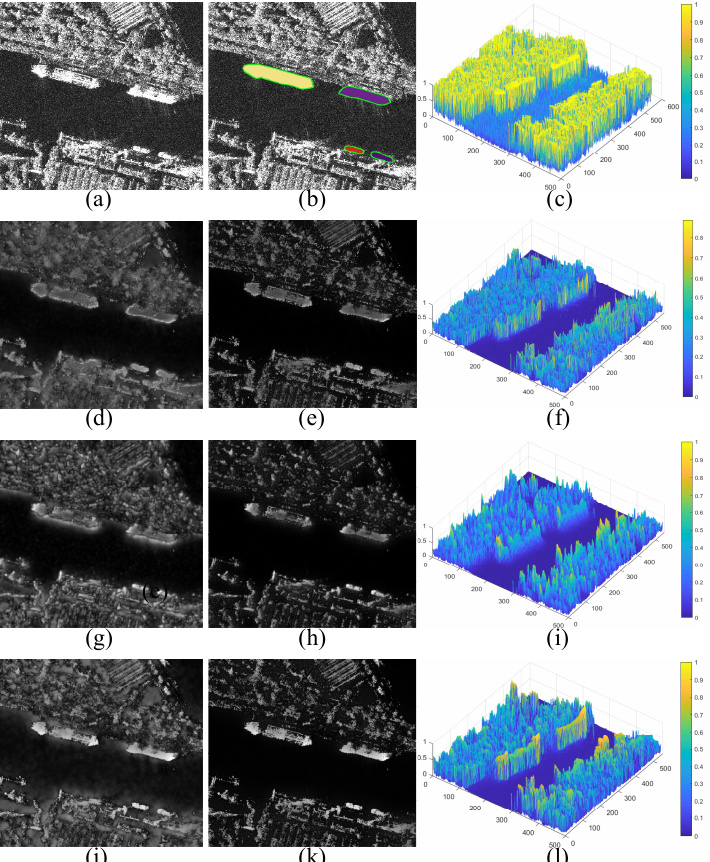
Figure 6. Saliency enhancement results with different methods. ( a ) SAR image. ( b ) Ground truth of ships. ( c ) The mesh map of the SAR image intensity. ( d ) Saliency map obtained by DoG. ( e ) Final saliency enhancement result obtained by DoG. ( f ) The mesh map of ( e ). ( g ) Saliency map obtained by Itti. ( h ) Final saliency enhancement result obtained by Itti. ( i ) The mesh map of ( h ). ( j ) Saliency map obtained by DoAP. ( k ) Final saliency enhancement result obtained by DoAP. ( l ) The mesh map of ( k